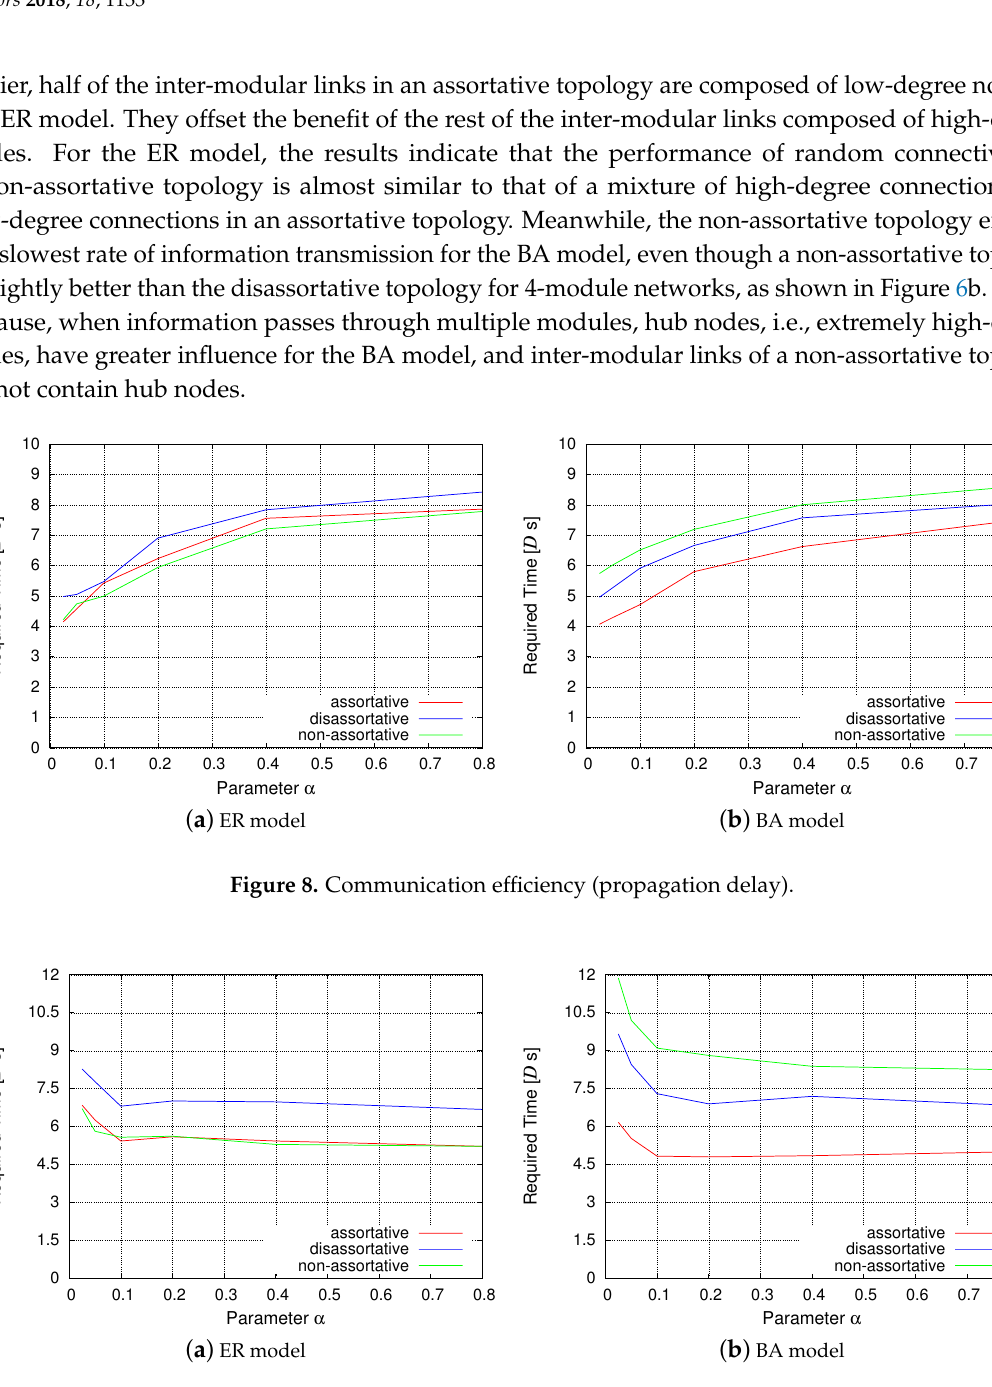
Figure 9. Communication efficiency (service